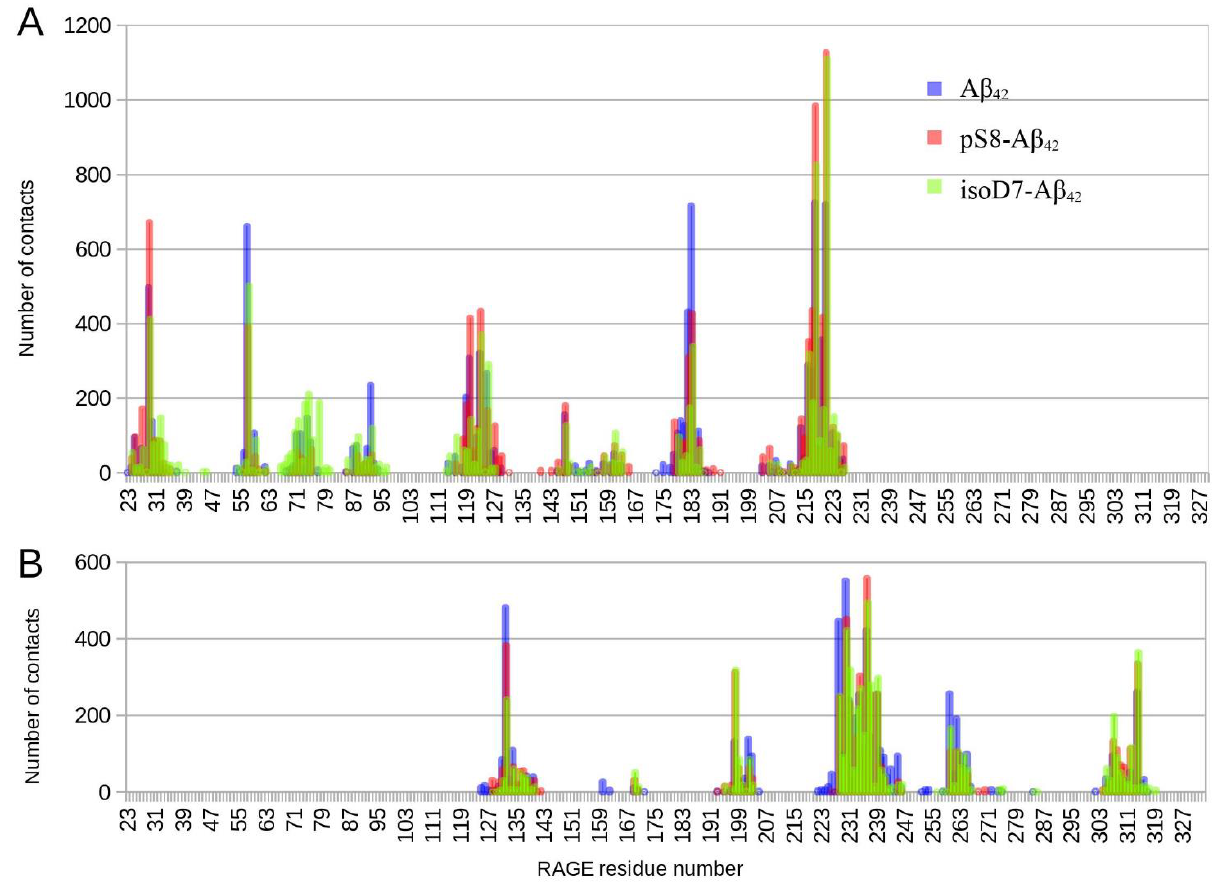
Figure 2. Contact frequency histogram for targeted docking of the Aβ 42 isoforms to the previously obtained interaction area of the RAGE protein performed with PatchDock server and analyzed by QASDOM software. The 30 best complexes with each isoform have been used for the analysis. ( A ) results for targeted docking to Interface 1, ( B ) results for targeted docking to Interface 2. Contacts with Aβ 42 are colored blue, contacts with pS8- Aβ 42 are colored red and contacts with isoD7- Aβ 42 are colored green.